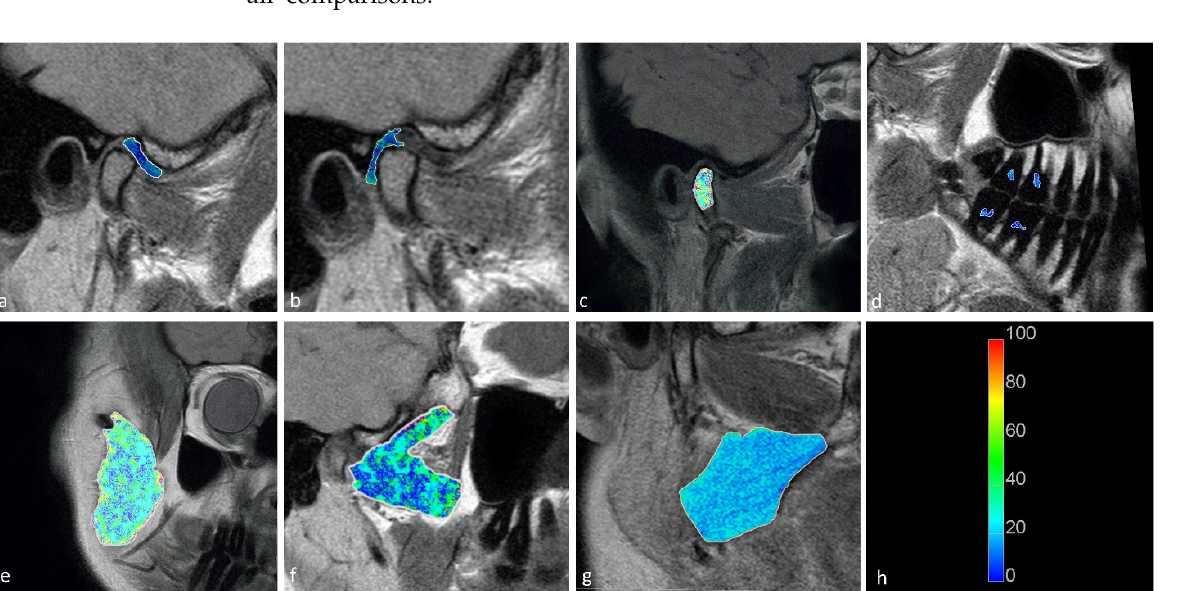
Figure 4. Short fraction components for the ( a ) disk; ( b ) retrodiscal tissue; ( c ) bone marrow of the condyloid process; ( d ) pulp; ( e ) m. masseter; ( f ) m. pterygoideus lateralis; and ( g ) m. pterygoideus medialis. ( h ) Color scale showing the reference values.